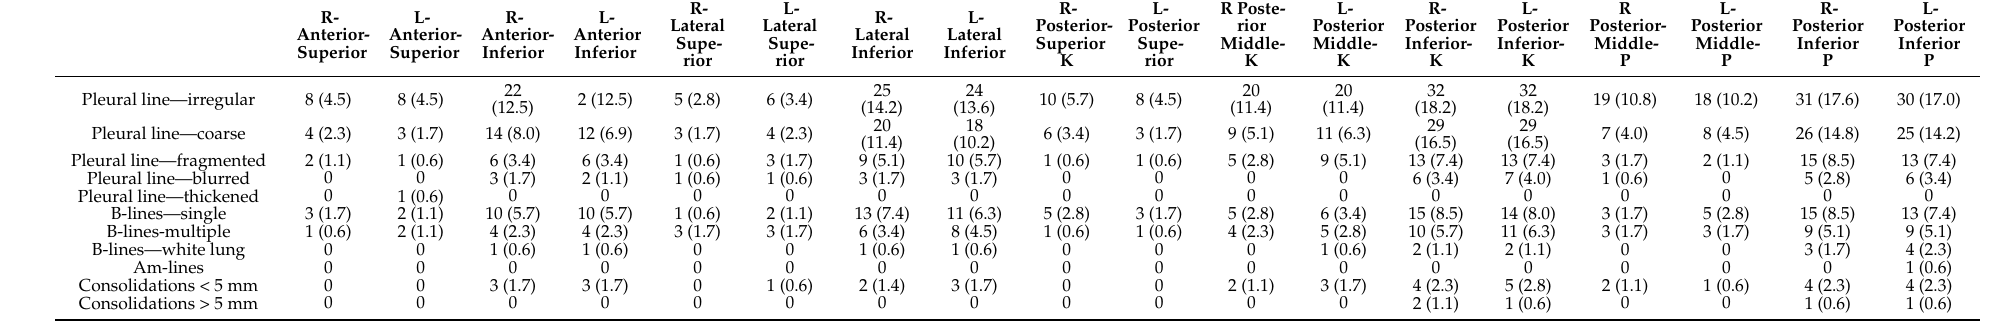
Table 7. Analysis of the frequency n (%) of abnormalities depending on localization. The table includes numbers of detected cases; % of the sample is given in